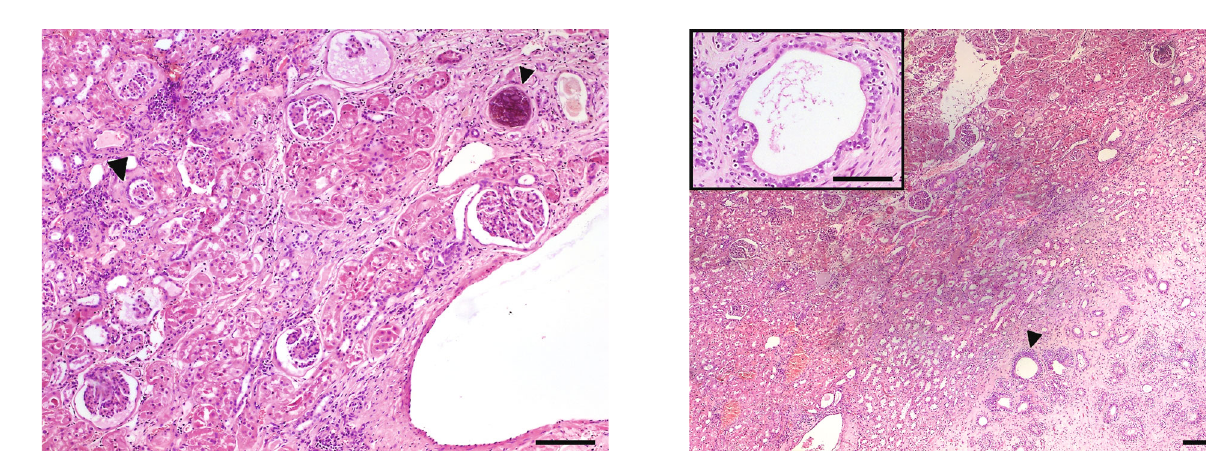
Figure 7: Histological aspect of the embryonal parenchyma of the left kidney: note that in the central portion of parenchyma, a well- developed Wol ffi an duct residue (arrow) is evolving, in the distal portion, into an epididymal-like structure. Insert: a Wol ffi an duct residue with a columnar epithelium and a lumen patent along its whole length is observed. H&E, scale bar = 600 μ m . Insert, scale bar = 150 μ m